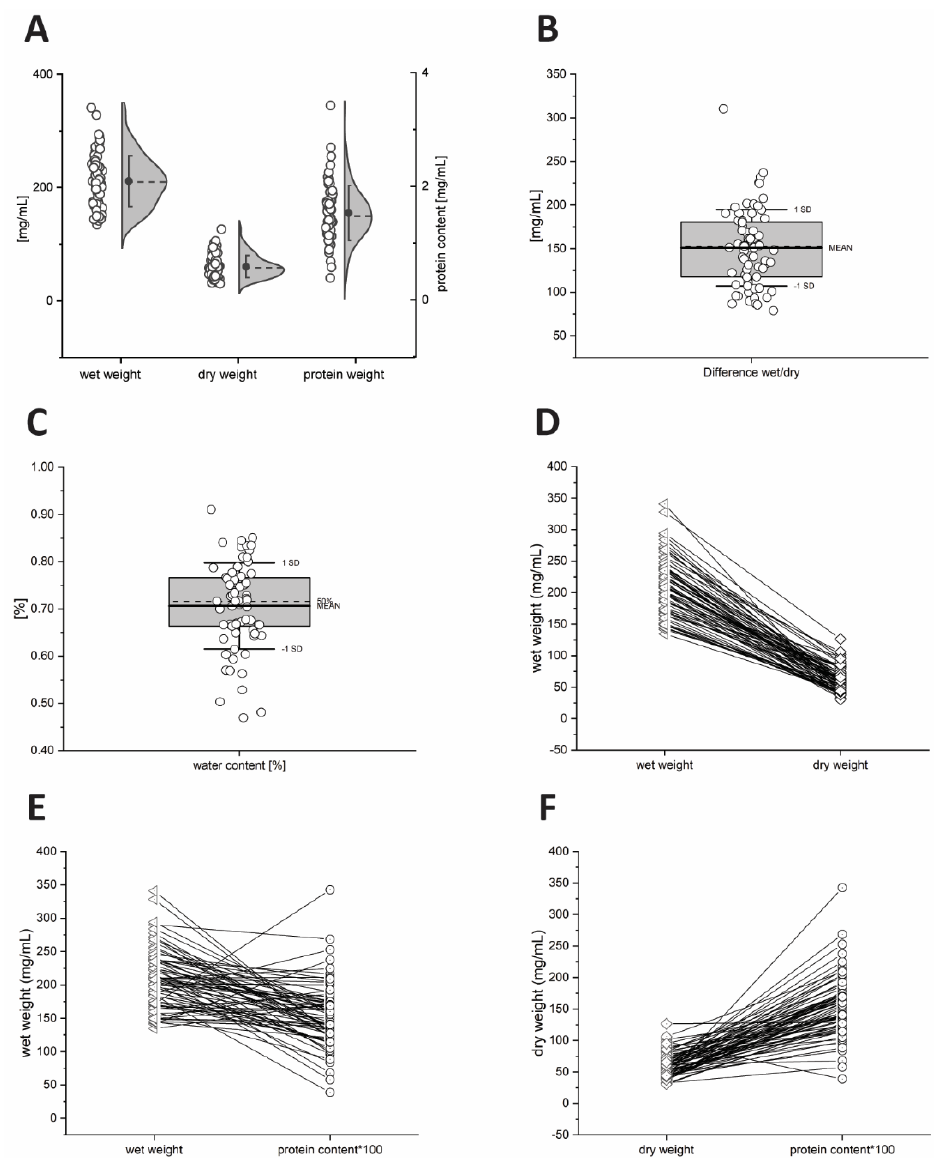
Figure 2. Weight distribution of 70 human feces samples from 42 healthy volunteers. Distribution of wet weight, dry weight, and protein content ( A ), difference of wet weight and dry weight ( B ), water content in percentage ( C ). Correlations of wet and dry weight ( D ), correlations of wet and protein content ( E ), correlations of dry, and protein content ( F ).